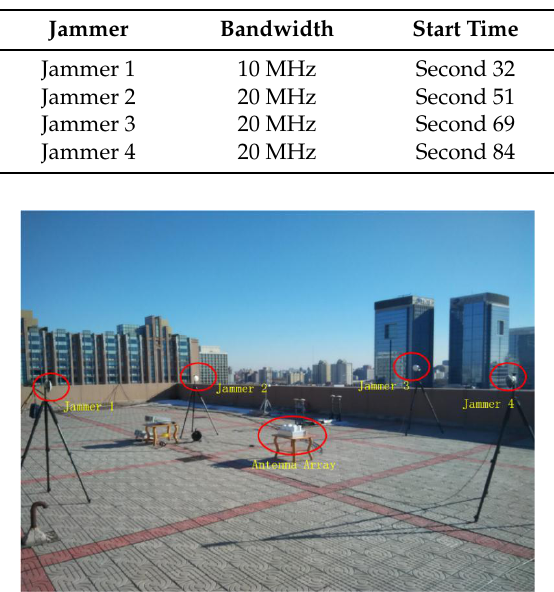
Figure 18. A photo of the experiment setup.